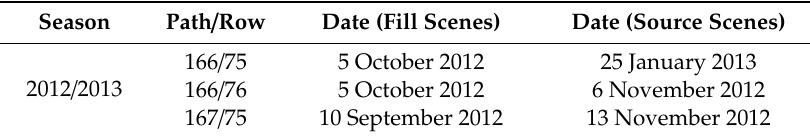
Table 2. Landsat 7 ETM + imagery used in the